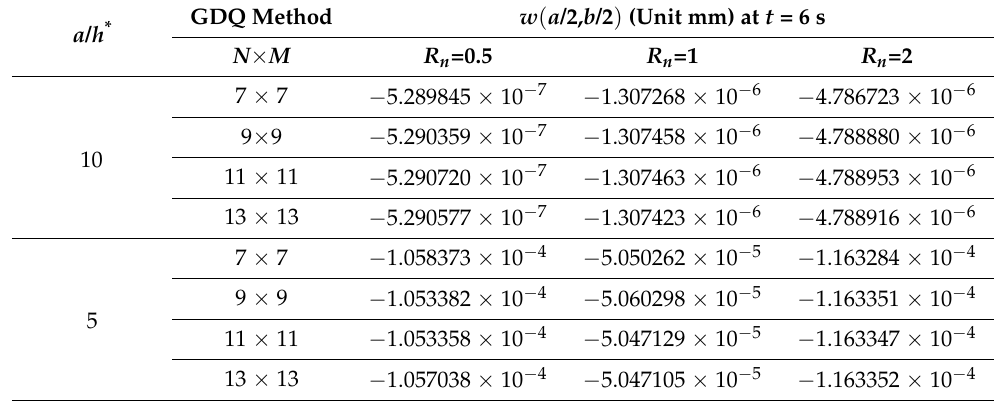
Table 1. Dynamic convergence of w ( a /2, b /2 ) considering advanced nonlinear k α .